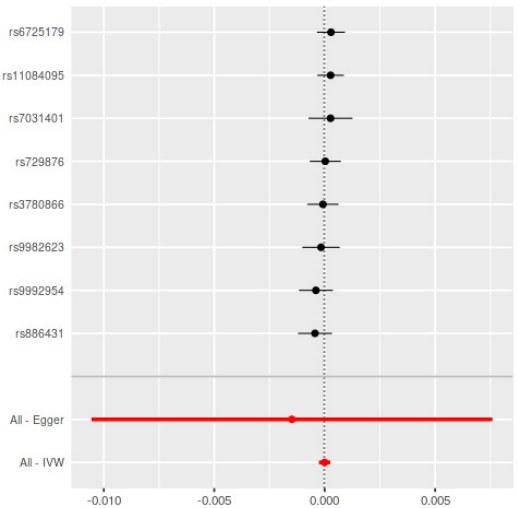
Figure 2. Mendelian Randomization summary effects for the risk of periodontitis associated with PD through random-effects approach for Munz et al. Summary effects were computed using an inverse-variance weighted (IVW) method from each individual SNP. Dots represent the coefficient and the extremities represent the 95% confidence interval of the odds ratio.